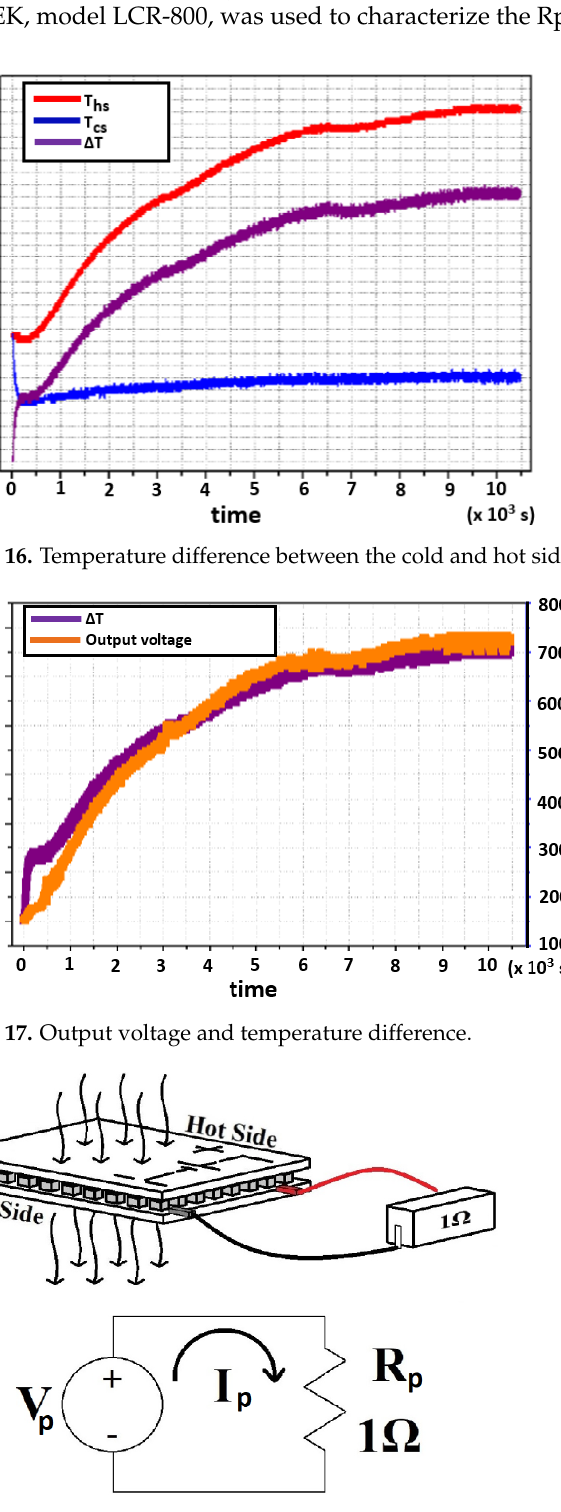
Figure 18. The electric diagram represents the measured voltage and current provided by the thermoelectric